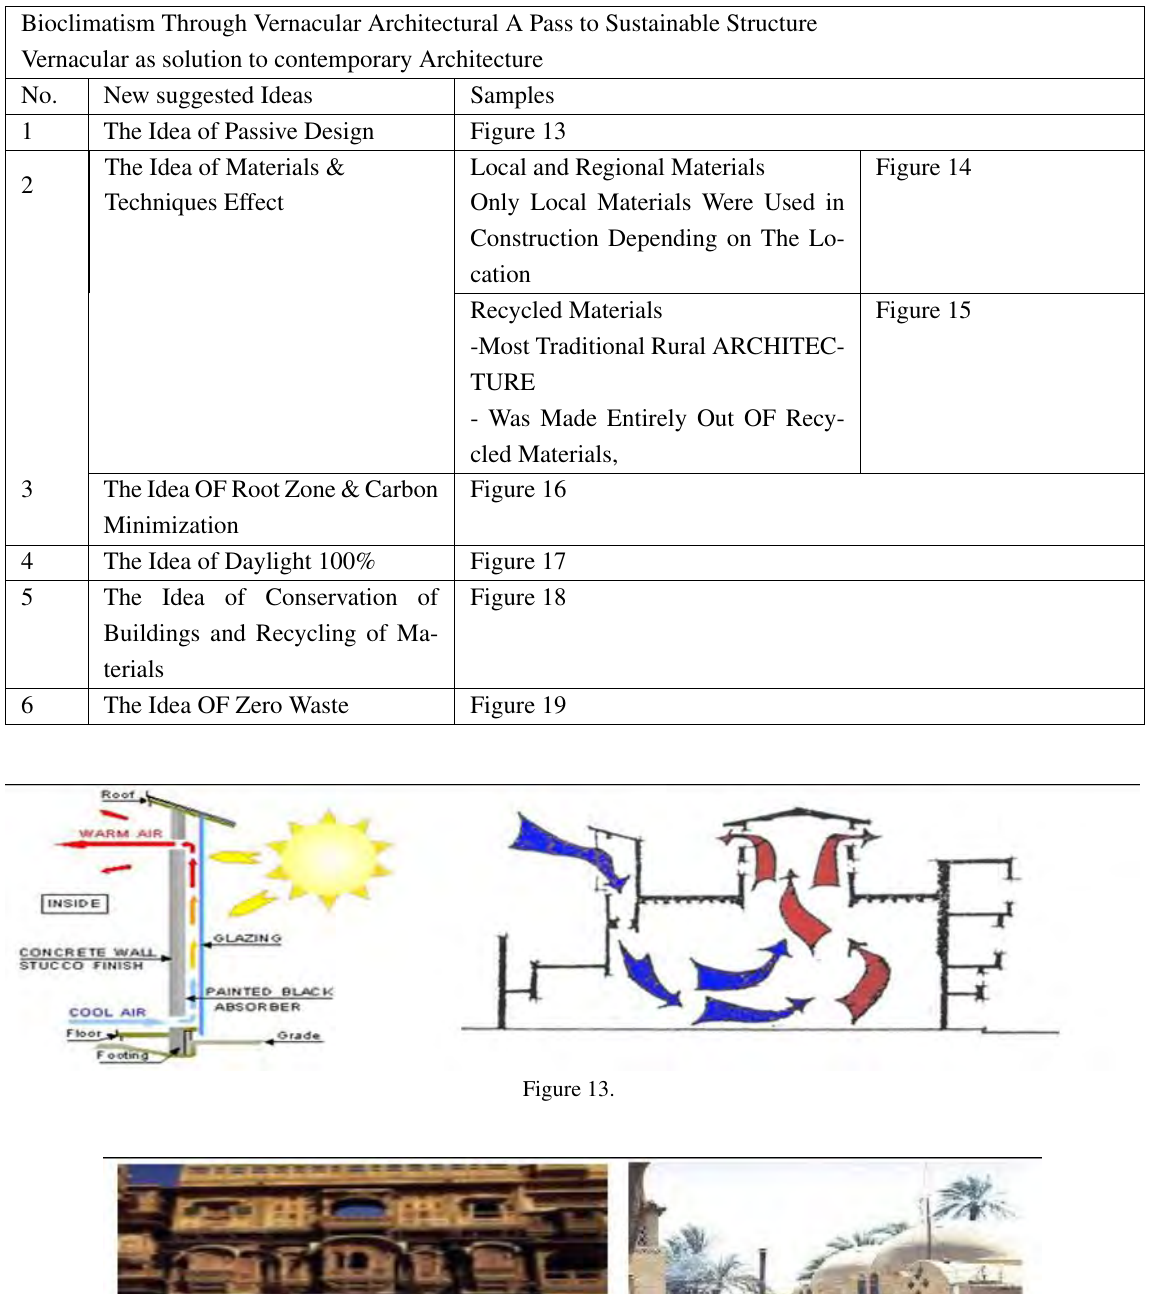
Table 3. Vernacular as solution to contemporary Architecture through